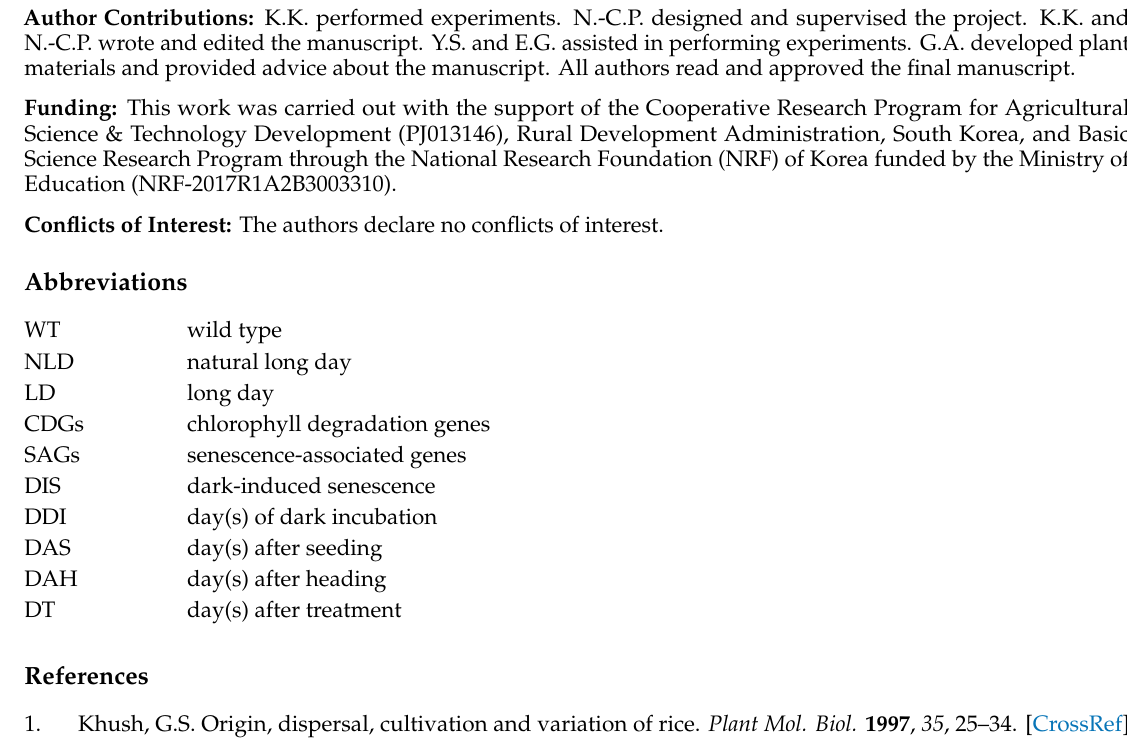
s1. Figure S1. Phylogenetic analysis of Arabidopsis NAC and rice NAC protein sequences. Figure S2. Expression profiles of rice NAC TFs throughout the growth period in the field. Figure S3. Amino acid sequence alignment of ONAC096 proteins. Figure S4. T-DNA insertion onac096 mutants. Figure S5. Altered expression of CDGs and SAGs in onac096 and ONAC096- OX plants. Table S1. Primers used in this